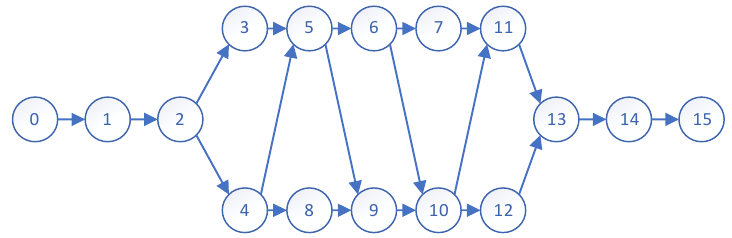
Figure 3. Hasse diagram with N = 16.